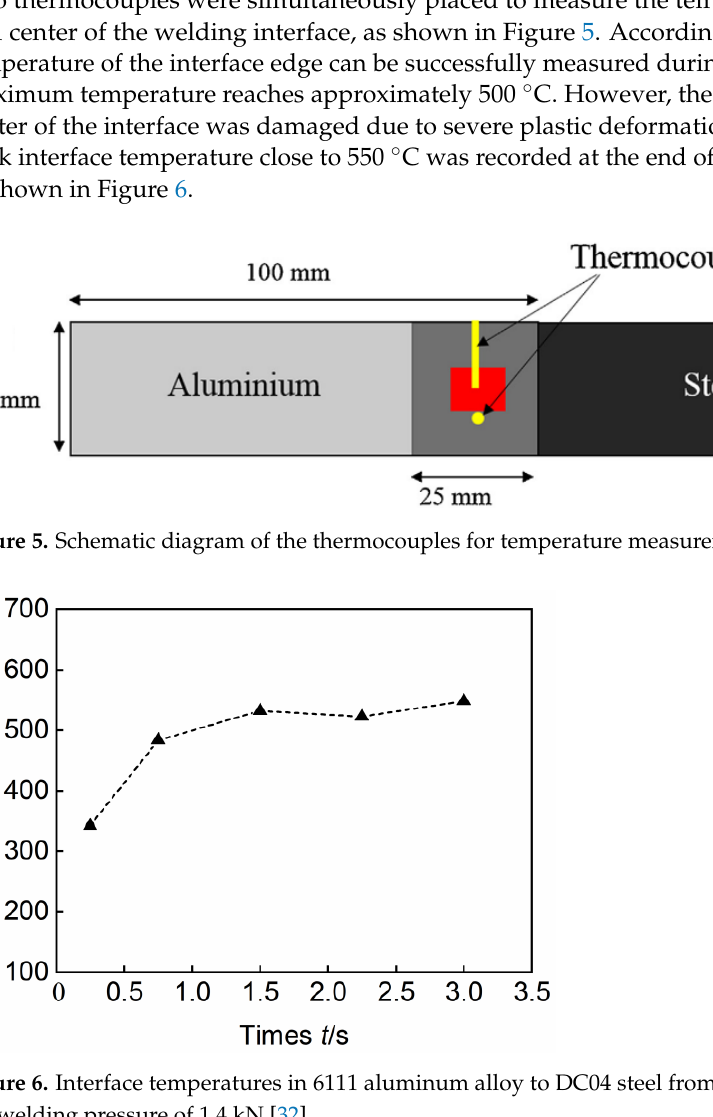
Figure 7. Temperature field according to thermal imaging at the welding time of 1.5 s and 3.0 s [33]. Wang et al. [34] found no obvious changes in the interface temperature by changing the specimen placed direction (vertical to or parallel to the vibration direction), since the frictional heat between the sonotrode and the workpiece has not changed, as shown in Figure 8. Satpathy et al. [22] reported that the interface temperature of the AA3003 alumi- num alloy/304 stainless steel joint was significantly increased by inserting the Cu inter- layer. Moreover, the peak temperature of dissimilar joints with interlayer reached its max- imum of 592 °C due to increased friction caused by the Cu interlayer.